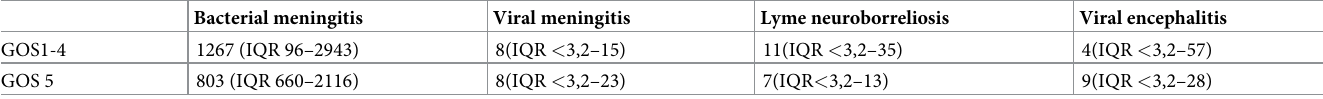
Table 5. PTX3 median values at different Glasgow Outcome